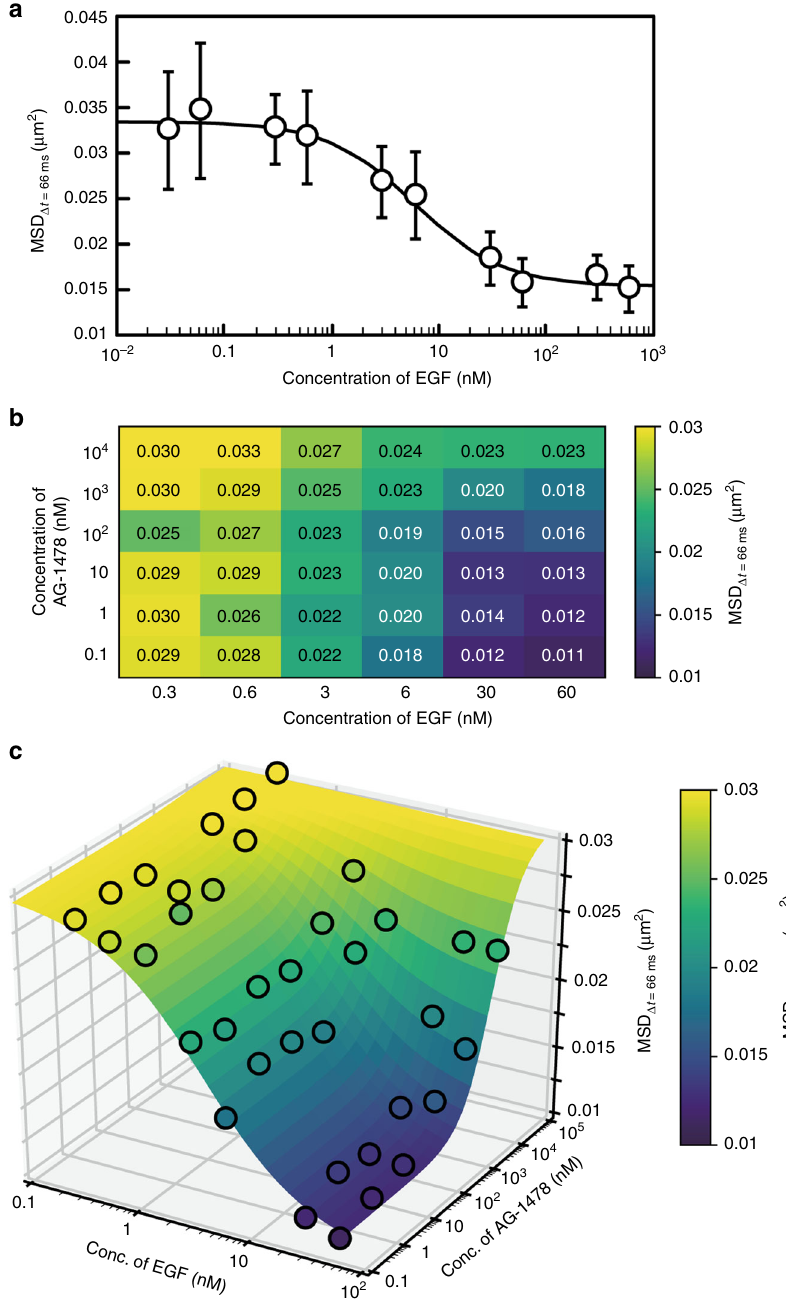
Fig. 3 Pharmacological parameters obtained by the automated apparatus. a Dose – response curve of the MSD at Δ t = 66 ms showing clear dependence on the EGF concentration. In total, 18 cells were analyzed for each data point. Error bars: SD. The curve was calculated from Eq. (14), and the obtained parameters are shown in Supplementary Table 4. b , c Antagonistic effects of EGF and the inhibitor (AG1478) on the MSD at Δ t = 66 ms of EGFR mapped in two-dimensional ( b ) and three-dimensional ( c ) space. Colors correspond to the MSD at Δ t = 66 ms according to the color bar. Dots and the surface indicate the measured data and fi tted curve calculated from Eq. (16), respectively. The obtained parameters are shown in Supplementary Table 5. In total, three cells were used for each data